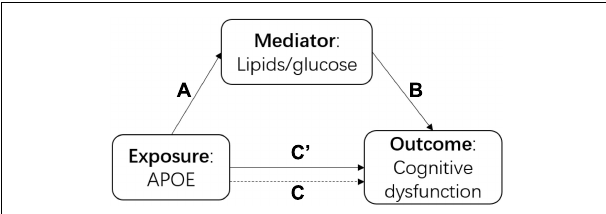
FIGURE 1 | The diagram of the causal mediation analysis of APOE on cognitive function. A indicated the association between APOE and cholesterol; B indicated the association between lipids/glucose and cognitive function; C’ indicated the association between APOE and cognitive function after adjusted for lipids/glucose; C indicated the association between APOE and cognitive function without adjustment of